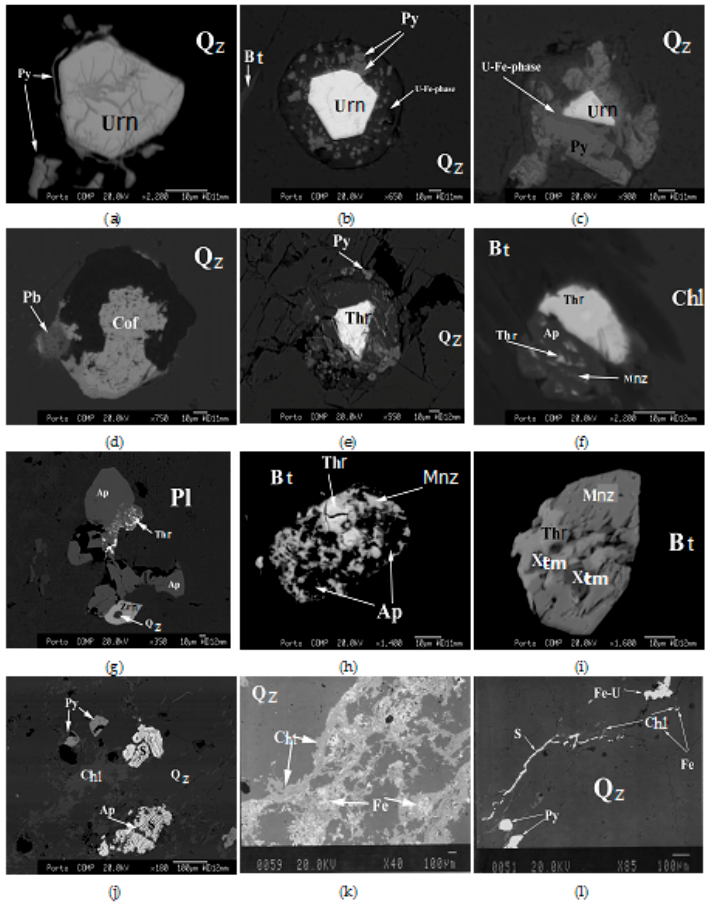
Figure 3. Backscattered images of minerals from the Variscan granite ( a – i ) and related mineralized hydrothermal quartz veins ( j – l ), central Portugal. Symbols: Ap: apatite, B: biotite, Cl: chlorite, Cof: coffinite, Fe: Fe oxyhydroxides, Fe-U: U-bearing Fe oxyhydroxides, Mon: monazite, Py: pyrite, Pb: Pb oxide, Q: quartz, S: saleeite, meta-saleeite, and Fe-saleeite, Th: thorite, U: uraninite, U-Fe-phase: U-Fe bearing phases, Xe: xenotime, Z: zircon. ( a ) Zoned crystal of uraninite (Urn) enclosed in quartz (Qz) grain, with the radioactive damage zone filled with pyrite (Py); ( b ) Fractured and zoned crystal of uraninite (Urn) enclosed in quartz (Qz); ( c ) Crystal of uraninite (Urn) enclosed in fractured quartz (Qz), associated with U–S-Fe- phases (U–Fe-phase) and pyrite (Py); ( d ) Corroded crystal of coffinite (Cof) enclosed in fractured quartz (Qz), associated with Pb oxide; ( e ) Subhedral crystal of thorite (Thr) with the radioactive damage zone filled with late pyrite (Py). Thorite is enclosed in fractured quartz (Qz) grains; ( f ) Apatite (Ap) replaced by monazite (Mnz), which is replaced by thorite (Thr), enclosed in biotite (Bt), and enclosed in chloritized (Chl) biotite (Bt); ( g ) Fractured crystal of apatite (Ap) replaced by thorite (Thr) and associated with zircon (Zrn), enclosed in plagioclase (Pl); ( h ) Fractured crystal of apatite (Ap), replaced by monazite (Mnz), which is replaced by thorite (Thr), and enclosed in biotite (Bt); ( i ) Fractured crystal of monazite (Mnz), replaced by thorite (Thr) and xenotime (Xtm), and enclosed in chloritized biotite (Bt); ( j ) Saleeite (S) replacing apatite (Ap), and filling quartz (Qz) fractures. Chlorite (Chl) enclosed in quartz; ( k ) Chlorite (Chl) weathered to Fe oxyhydroxides (Fe, filling fractures in the mineralized quartz (Qz) veins); ( l ) Saleeite (S), filling fractures in the mineralized quartz (Qz) veins, associated with U-rich Fe oxyhydroxides (Fe–U), pyrite (Py), and chlorite (Chl).